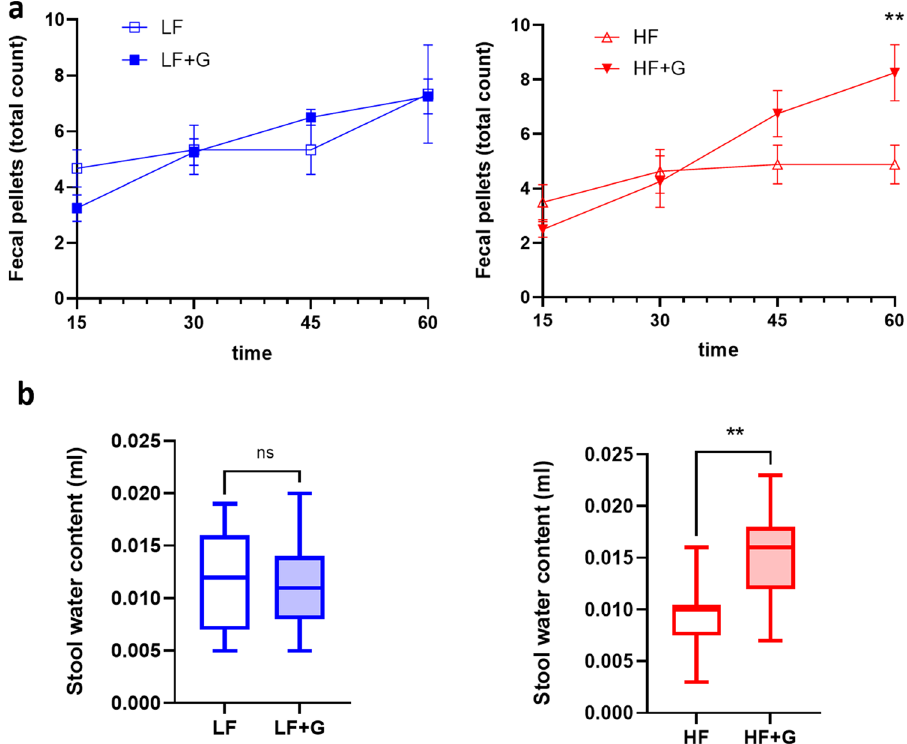
Figure 10. High fat exacerbates Giardia -induced increases in gut motility and stool water contents. ( a ) Colonic transit test measuring fecal pellet output. Total fecal pellet output per mouse over 1 h (time points: 15, 30, 45 and 60 min); n = 4 mice/group. ( b ) Water content of stools. Fresh fecal pellets were dried overnight at 60 °C and total stool water content was calculated by comparing wet/dry weight. n = 7–15 fecal pellets/group. LF = low fat control mice; LF + G = low fat infected mice; HF = high fat control mice; HF + G = high fat infected mice. Data are shown as box plots with min/max whiskers. ns = non-significant; ** p <